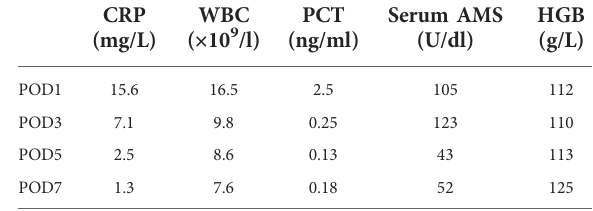
TABLE 2 The blood results.